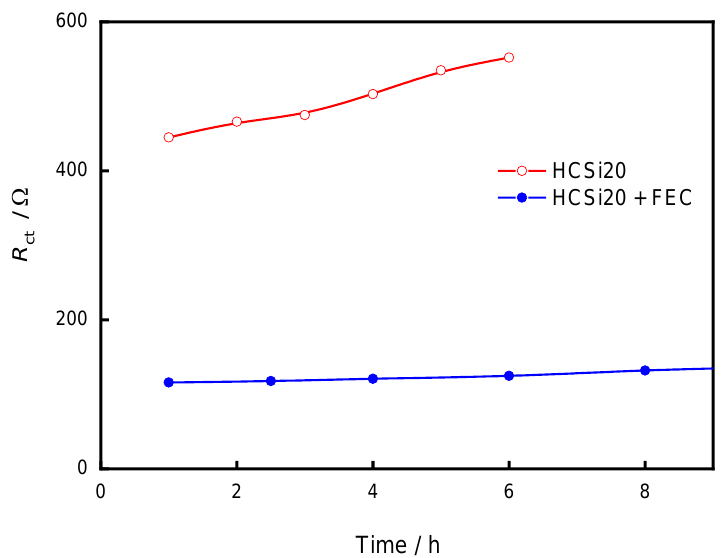
Figure 14. Charge transfer resistance (R ct ) change over long period of lithiation for electrode HCSi20 and HCSi20 with the addition of FEC.